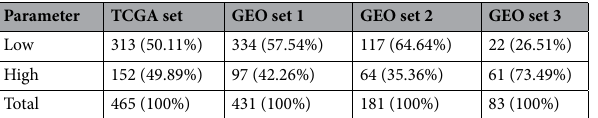
distance metastasis ( P = 0.045, Fig. 6G). In addition, with the increase of TNM grade ( P < 0.001, Fig. 6D) and tumor size ( P < 0.001, Fig. 6E), the immune risk score was also increased. There was no difference in risk score between patients aged ≤ 65 or > 65, with or without EGFR mutation, with or without EGFR mutation, smoking or non-smoking, and with or without chemotherapy. Relationship between the IRGPs and tumor‑infiltrating immune cells (TIICs). The most abun- dant TIICs were Macrophages (M0, M1, M2) (32.98%), followed by Plasma cells (17.23%) and resting memory CD4 T cells (9.70%). The proportions of Macrophages M0 ( P < 0.001), Macrophages M1 ( P < 0.001), activated